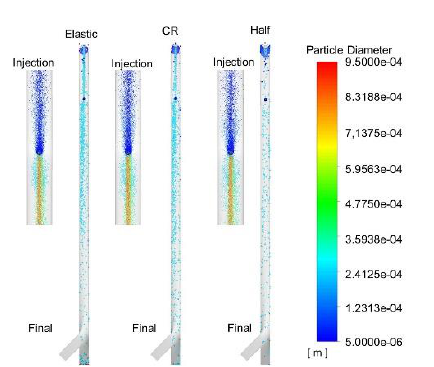
Fig. 4. Estimated pressure loss vs. experimental pressure loss for different turbulence models.